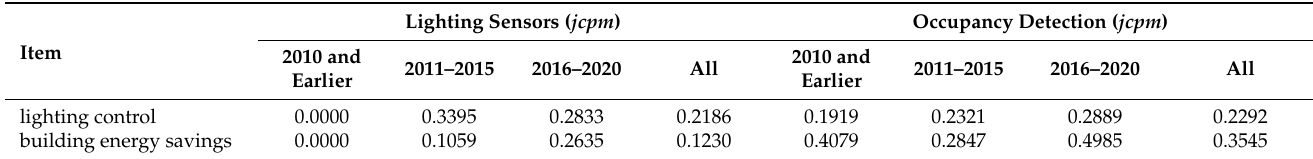
Table 9. Joint conditional probability measure ( jcpm ) of the items lighting sensors and occupancy detection networked with the items lighting control and building energy savings, determined by using VOSviewer.